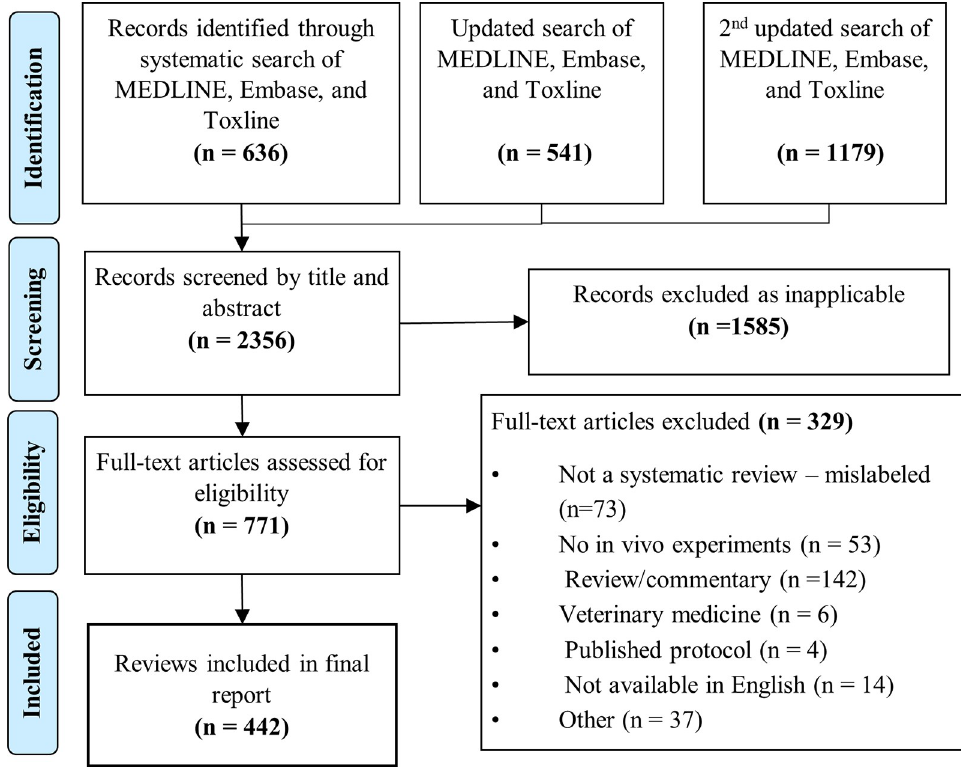
Fig 1. PRISMA flow diagram of study selection process. PRISMA, Preferred Reporting Items for Systematic reviews and Meta-Analyses.